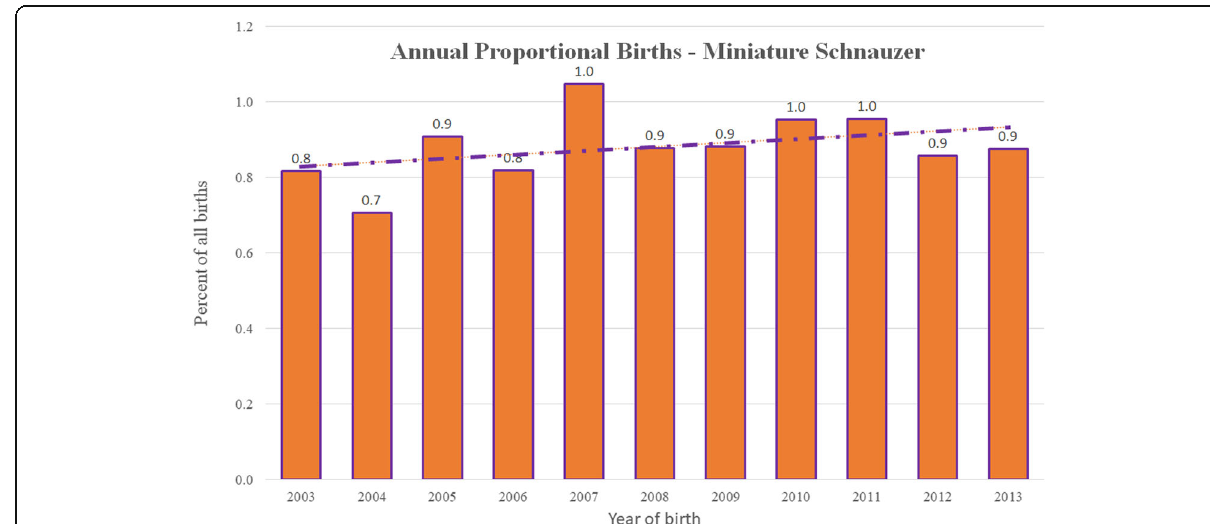
Fig. 1 Annual proportional birth rates (2003 – 2013) for Miniature Schnauzers ( n = 3857) among all dogs ( n = 455,557) attending UK